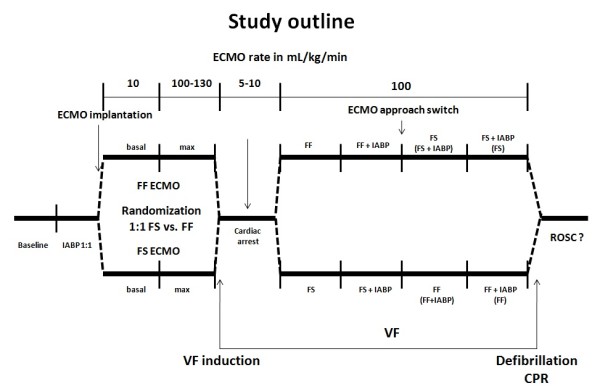
Outline of the study protocol. For an explanation see text. Vertical bars represent 15-minute intervals for respective measurement periods. CPR, cardiopulmonary resuscitation; ECMO, extracorporeal membrane oxygenation; FF, femoro-femoral; FS, femoro-subclavian; IABP, intraaortic balloon countepulsation; VF, ventricular fibrillation; ROSC, return of spontaneous circulation.